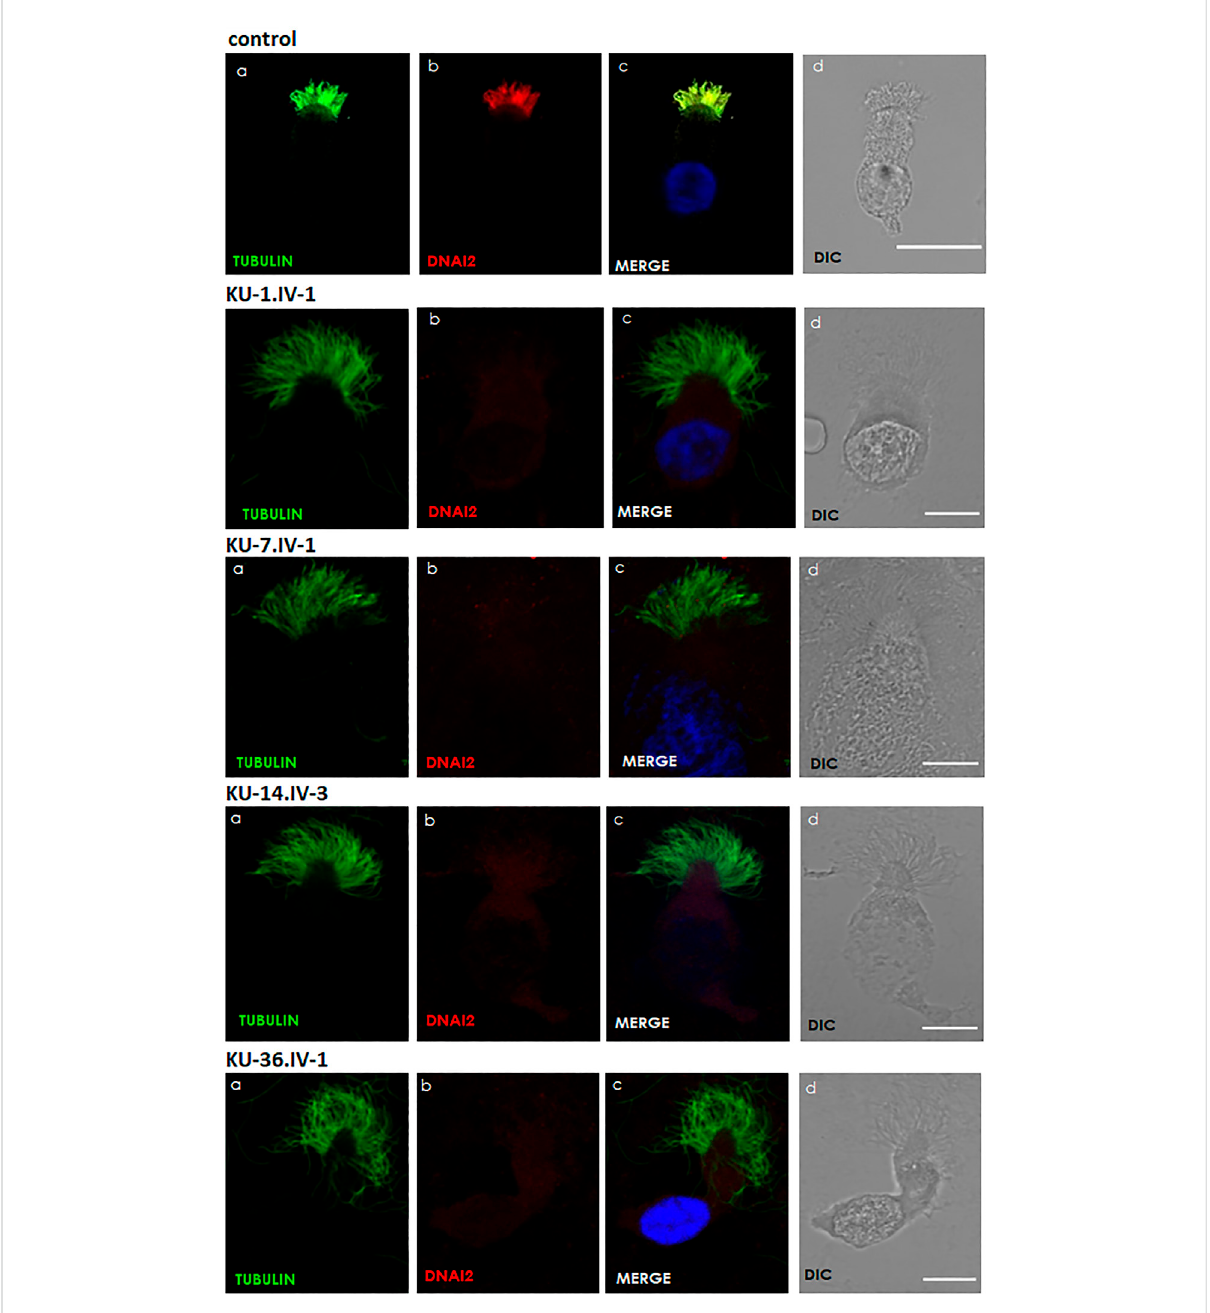
FIGURE 5 Immuno fl uorescenceimagesofprimaryrespiratoryepithelialcellsforPCDindividuals.TheIFwasperformedusingmonoclonalanti-acetylated α tubulin:panel (A) andpolyclonalanti-DNAI2:panel (B) antibodyforselectedPCDindividuals vs. healthycontrols.Asseeninthecontrol,themerged images: panel (C) show a yellow co-staining within the ciliary axoneme which indicates that both proteins co-localized within respiratory cilia compared with the images for PCD individuals that demonstrate an absence of anti-DNAI2 staining. Scale bar is 10 µm. (D) shows differential interference contrast fi gures (DIC) for analyzed